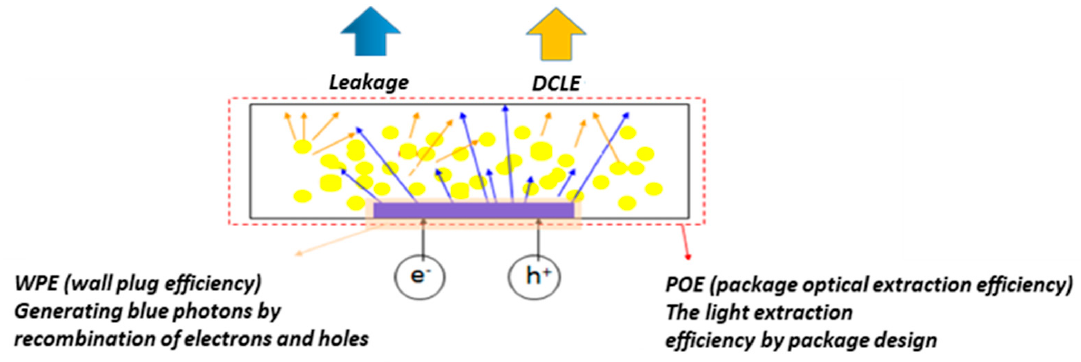
Figure 1. Schematic of a WLED structure.